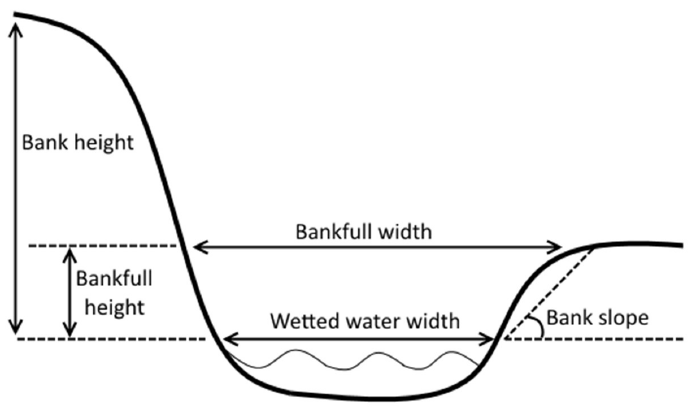
Figure 6. Schematic diagram showing the hydromorphological measures estimated at cross-section level with the proposed Structure-from-Motion framework. A full description of each measure can be found in Table